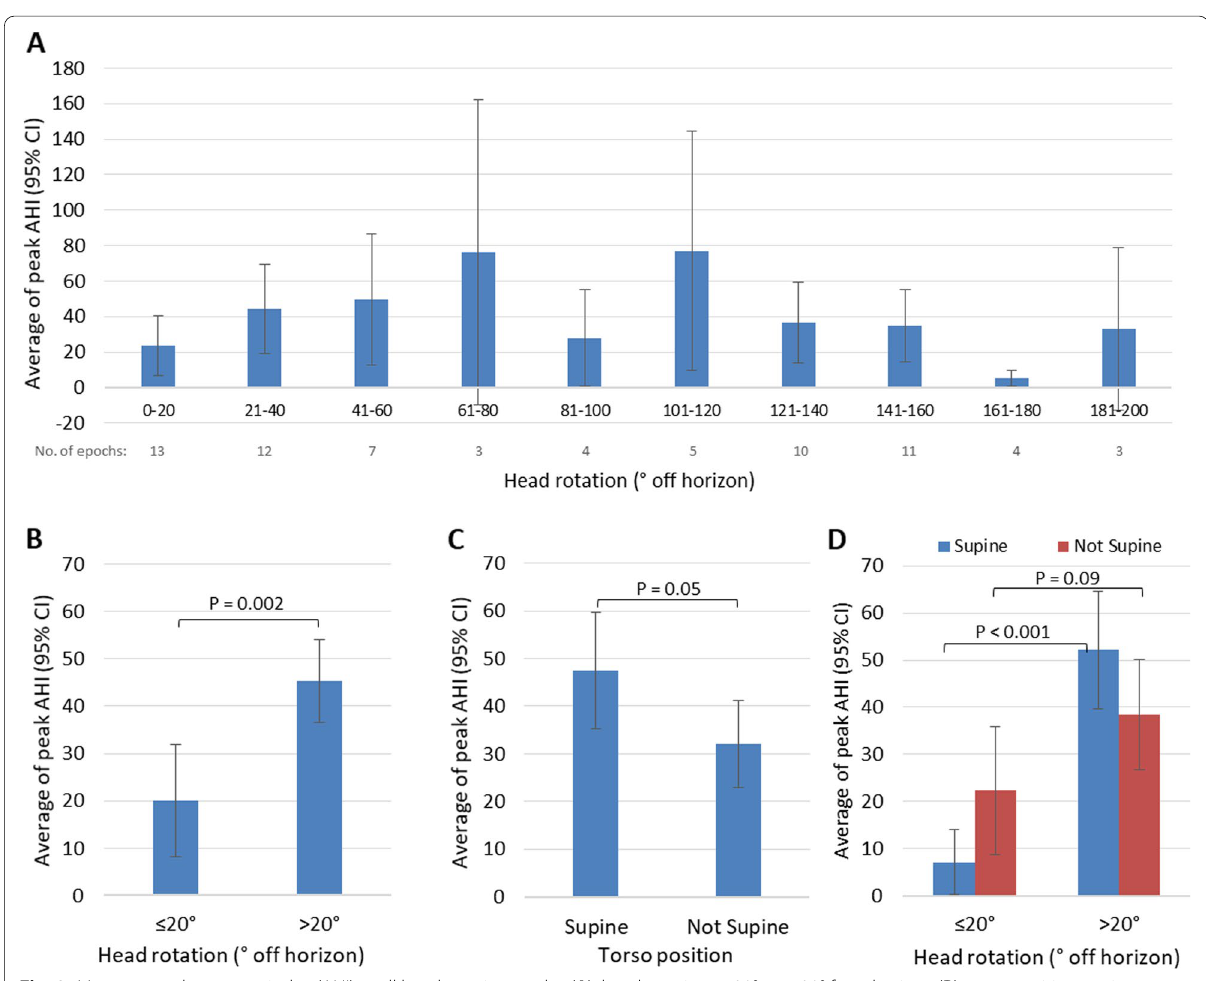
Fig. 3 Mean apnea-hypopnea index (AHI) at all head rotation angles ( A ), head rotation non-supine ( C ), and combination of head rotation angle and torso position ( D